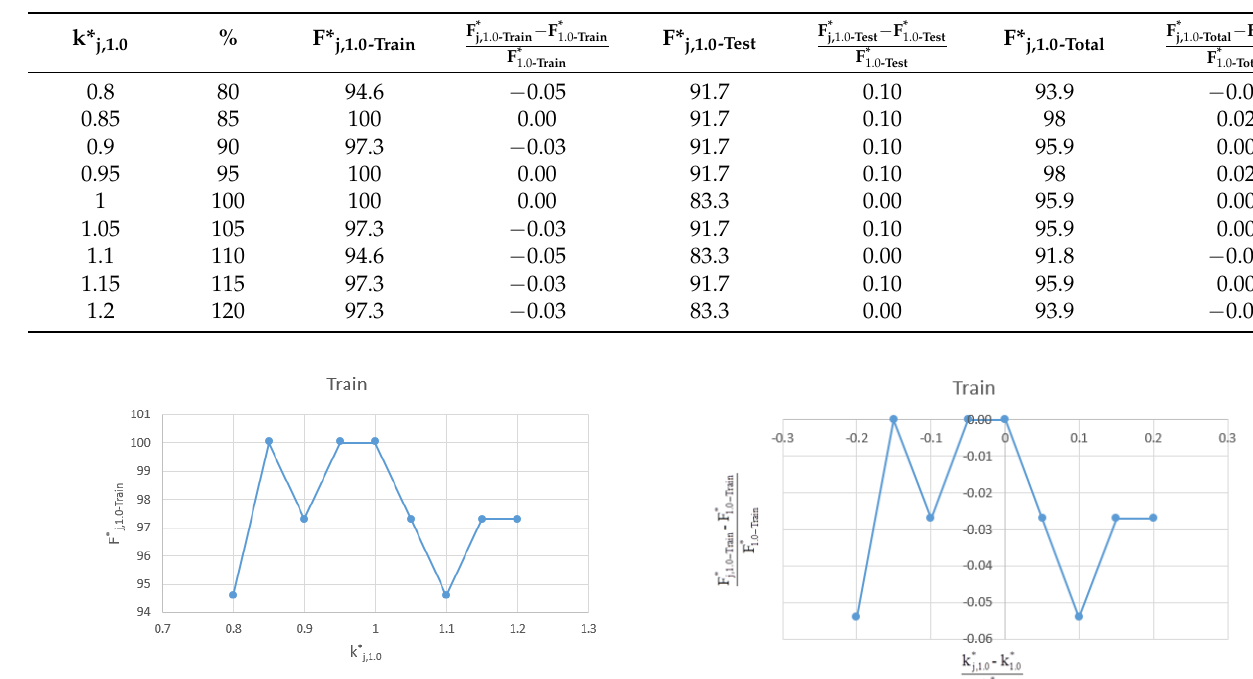
Table 6. Value of F* j,1.0-Train , F* j,1.0 − Test , and F* j,1.0-Total by varying k* 1.0 in the fixed range.